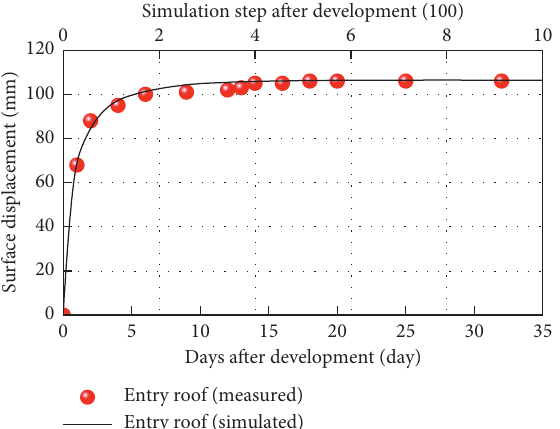
Figure 3: Comparison between the numerical simulation model and the field measuring